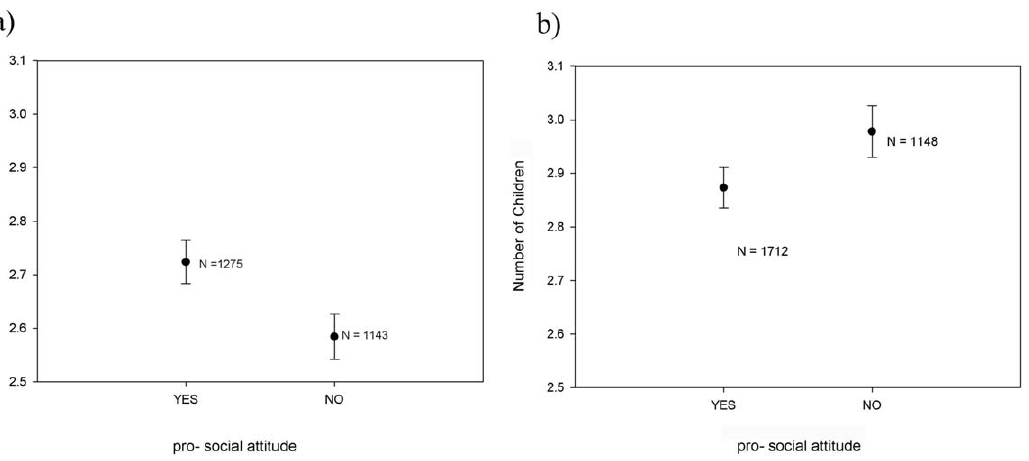
Figure 2. Offspring number (mean ± SE) of men exhibiting a pro-social attitude and men not exhibiting a pro-social attitude (a). Offspring number (mean 6 SE) of women exhibiting a pro-social attitude and women not exhibiting a pro-social attitude (b).